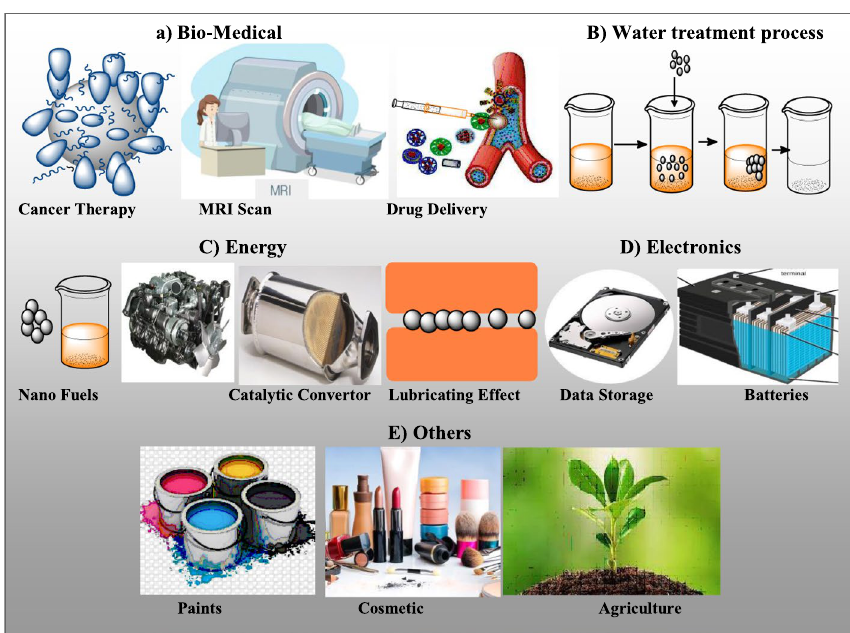
Fig. 2 Applications of magnetite nanoparticles in various